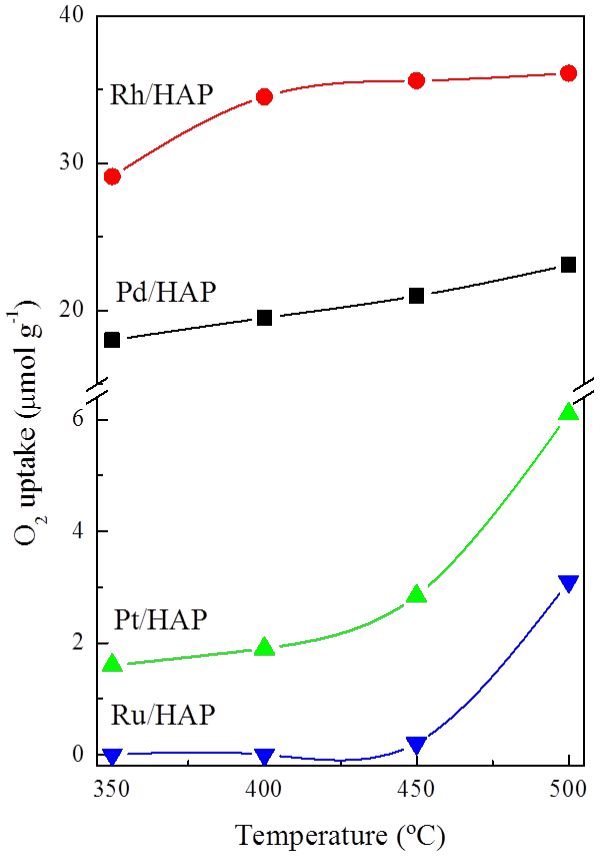
Figure 5. OSC studies on the noble metal catalysts.